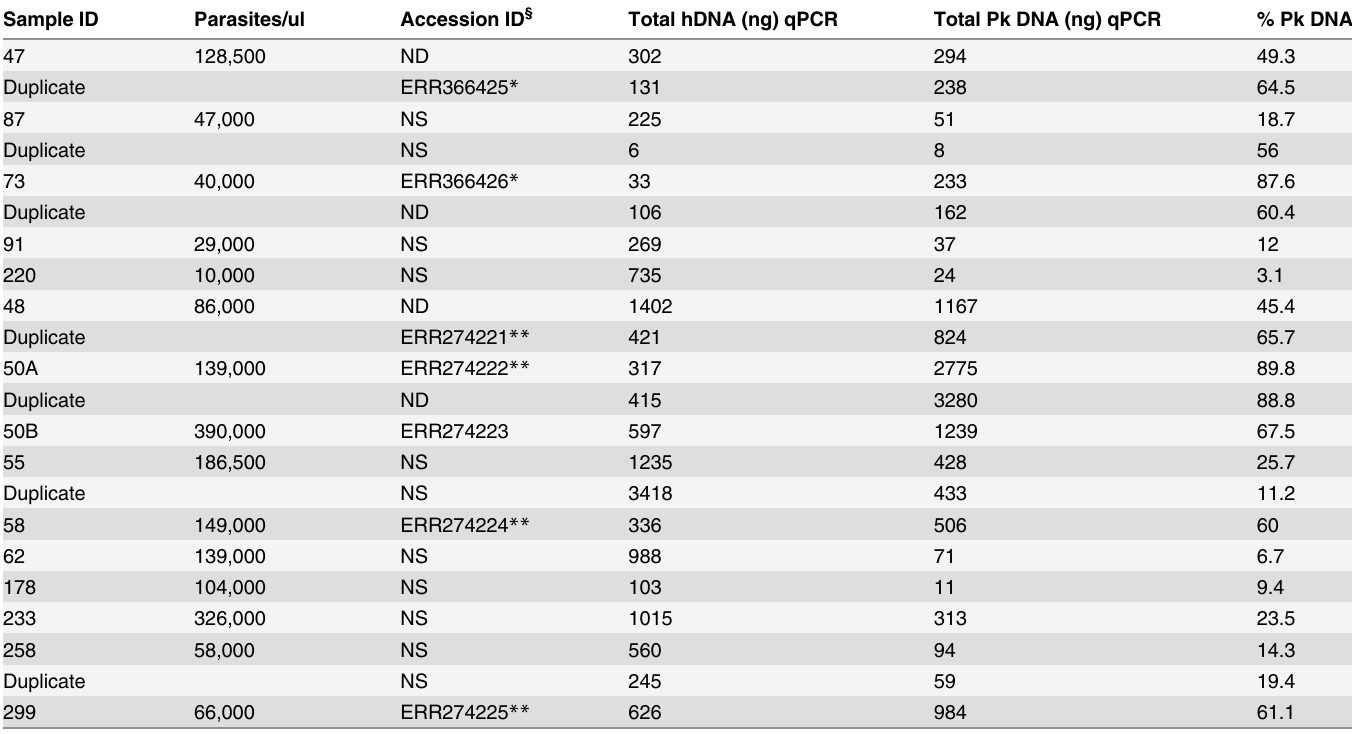
Table 1. Clinical samples human DNA depleted using the Whatman filtration